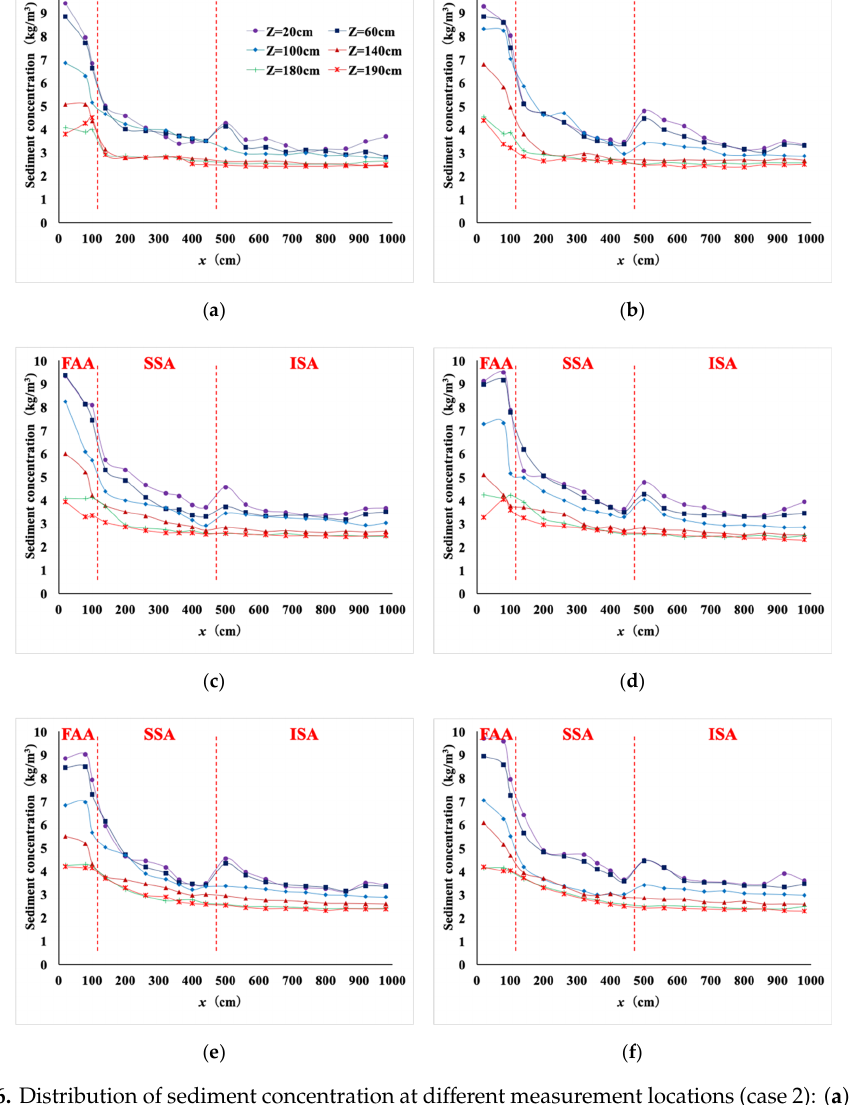
Figure 6. Distribution of sediment concentration at different measurement locations (case 2): ( a ) section of y = 20 cm, ( b ) section of y = 40 cm, ( c ) section of y = 80 cm, ( d ) section of y = 120 cm, ( e ) section of y = 160 cm, and ( f ) section of y = 180 cm.